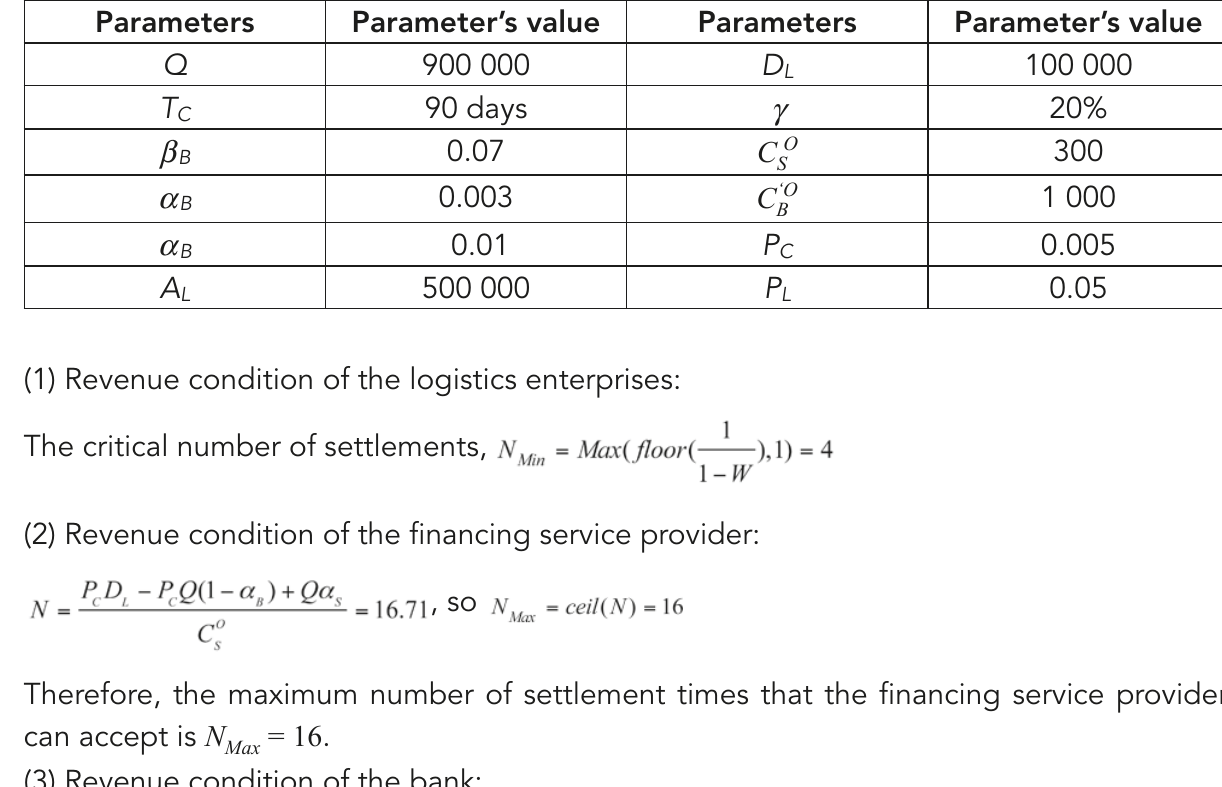
Table 1: Parameters of the